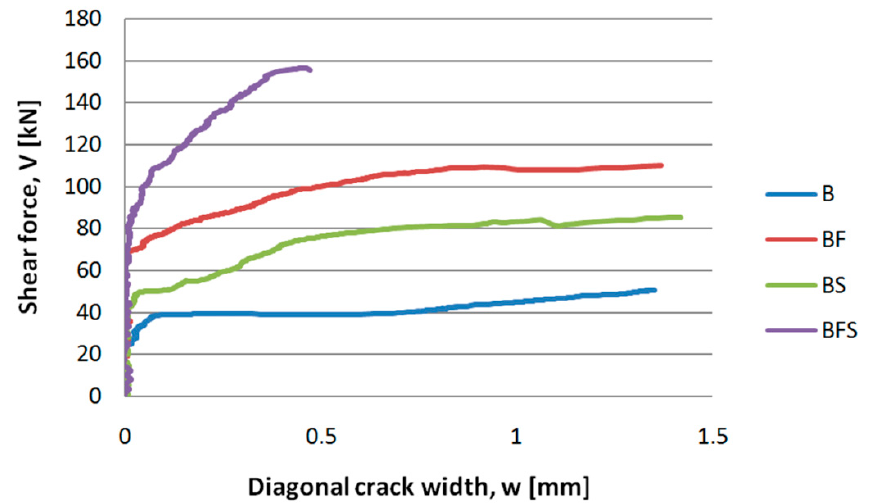
Figure 21. Shear force ( V ) versus diagonal cracks opening width ( w ) for selected B, BF, BS, and BFS series beams.